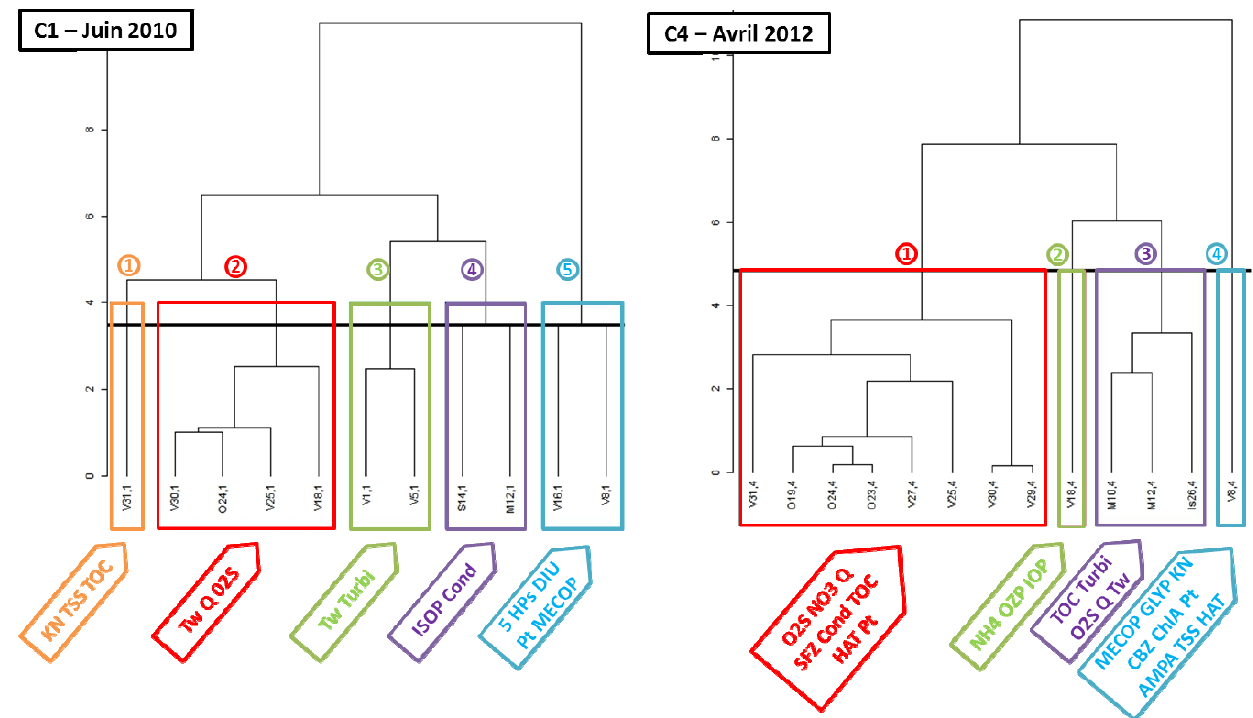
Figure 5. Results of HCPC during C1 and